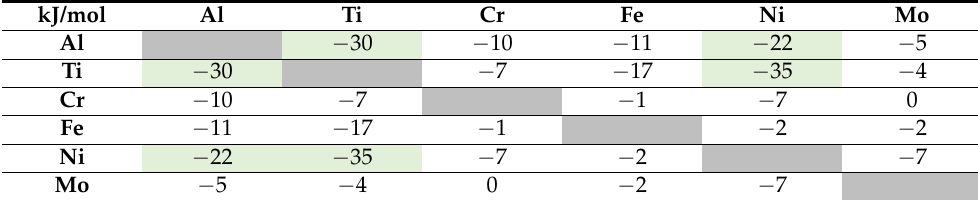
Table 2. Formation enthalpies of binary systems in the alloy